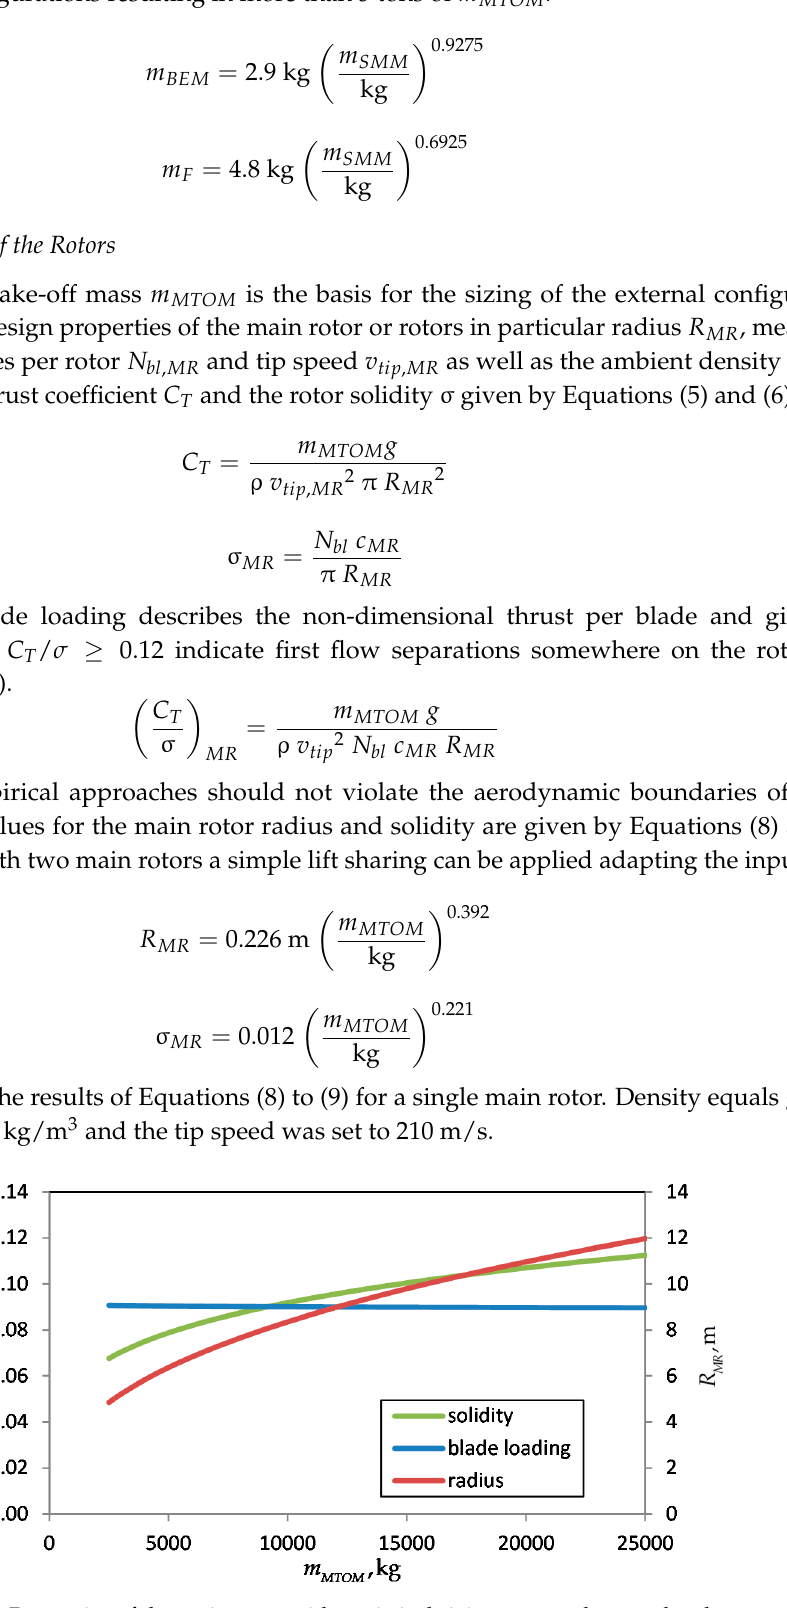
Figure 4. Properties of the main rotor with statistical sizing approach at sea level.